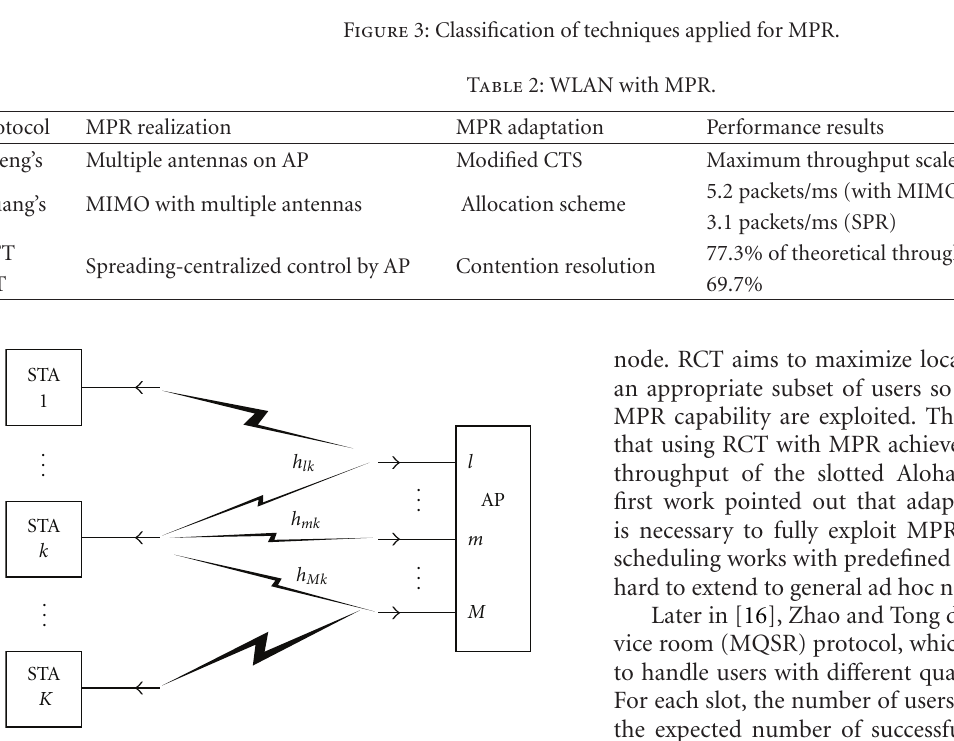
Figure 4: System configuration for uplink MPR in